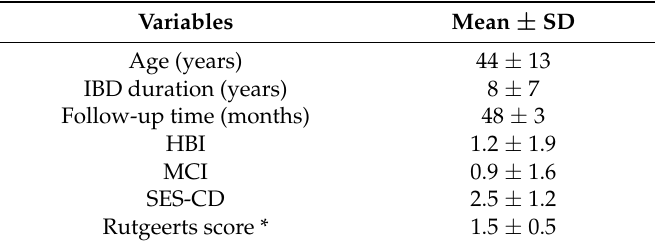
Table 1. Baseline demographic and clinical characteristics of the population with Inflammatory Bowel